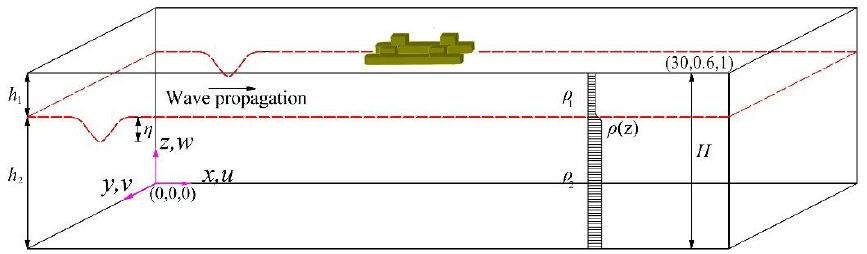
Figure 2. Schematic illustration of Internal Solitary Wave (ISW) propagation over a submerged platform. h 1 is the upper fluid depth, h 2 is the lower fluid depth, ρ 1 is the upper fluid density and ρ 2 is the lower fluid density.